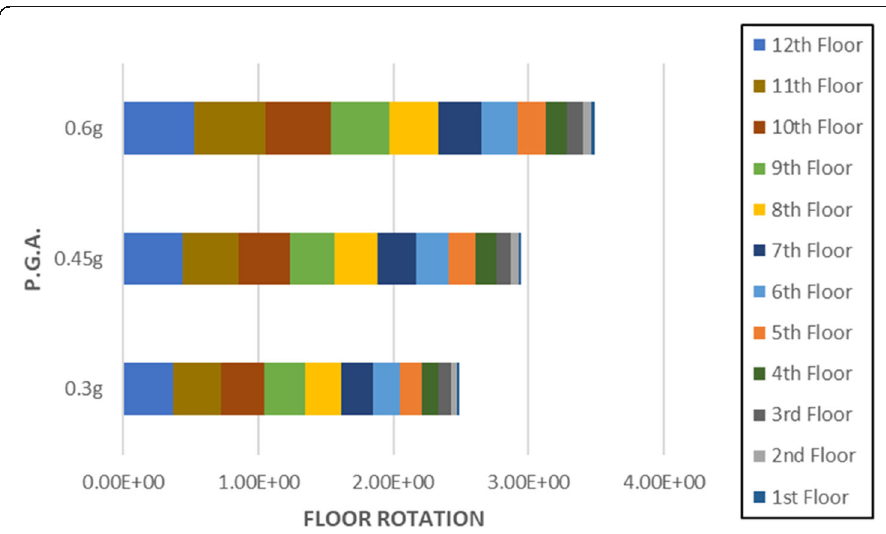
Fig. 30 Comparison of floor rotations — P.G.A. for (DS1-2, DS2-2, and DS3-2) (color should be used for this